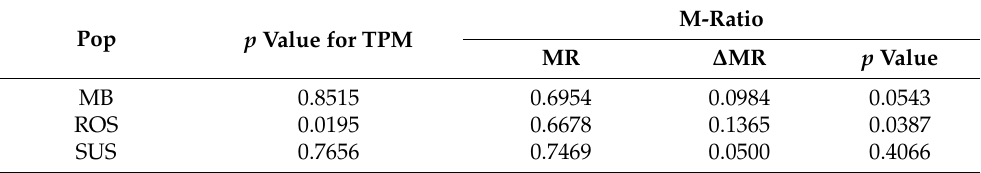
Table 3. Results of the bottleneck tests in B. humilis populations based on heterozygosity excess (TPM model with 78% of single step mutations) and M-ratio (the Garza–Williamson